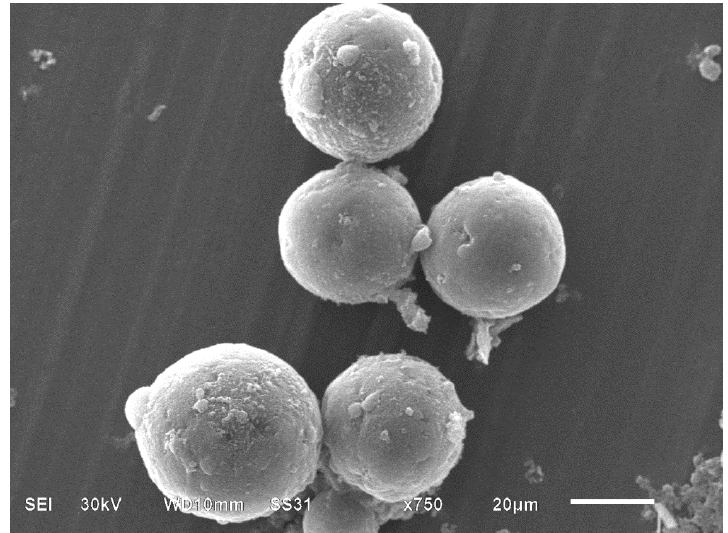
Figure 1. SEM image of magnetic PGMA-g-PPy microspheres.